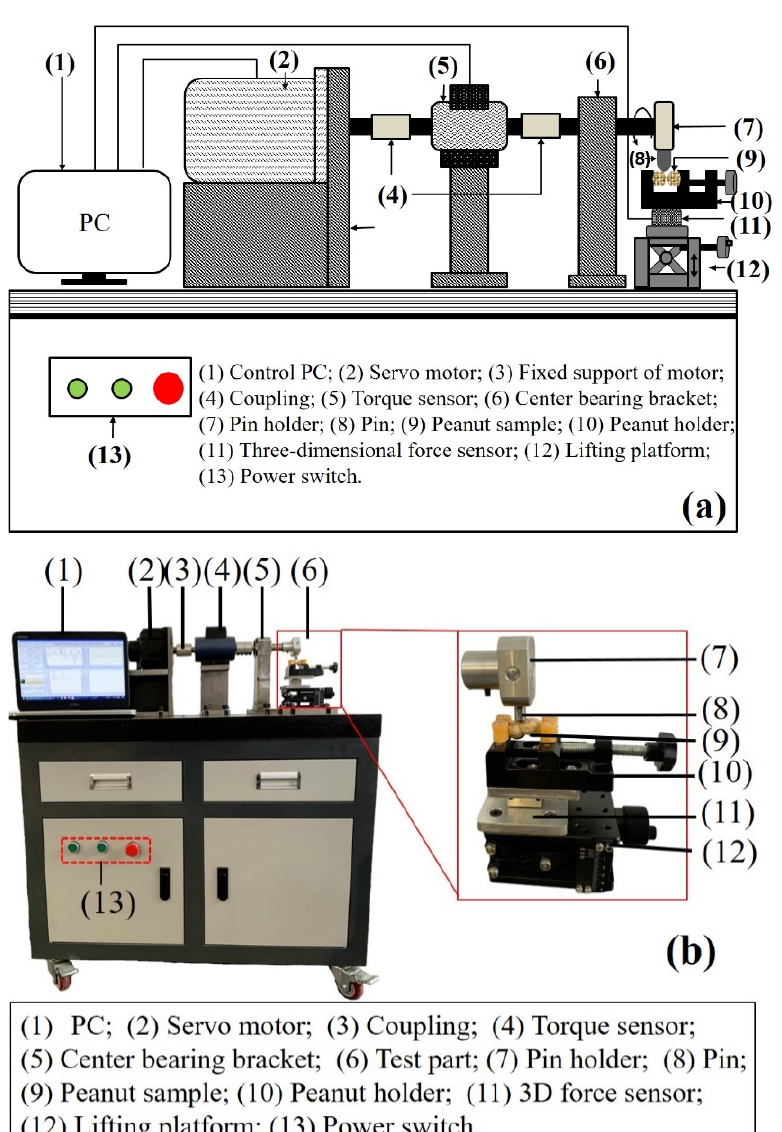
Figure 3. ( a ) Schematic and ( b ) photograph of the designed peanut-picking impact-friction